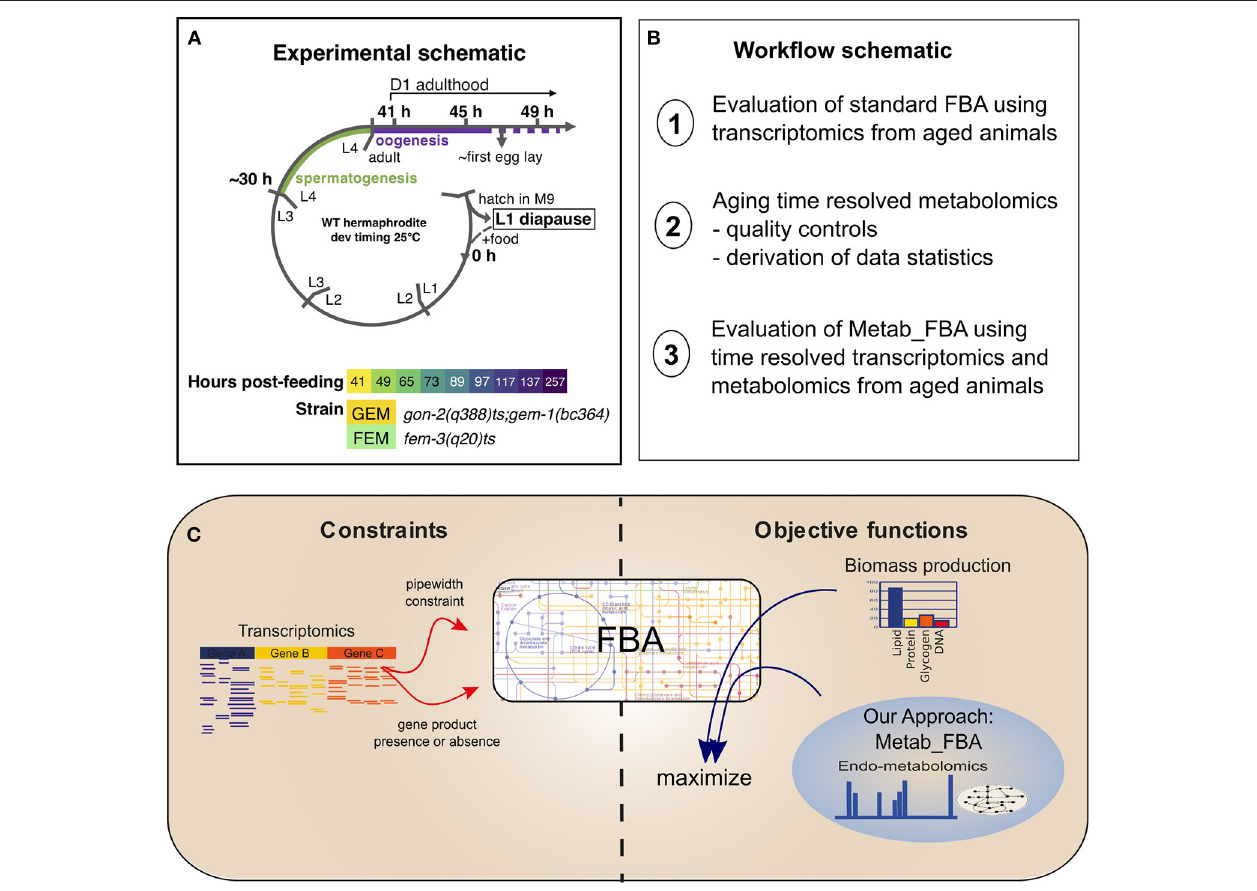
FIGURE 1 | Experimental schematic. (A) Our experimental design included two sterile strains with differing gonadal composition sampled from early D1 of adulthood (41h post-L1-feeding, which coincides with the very end of the L4 to adult molt) to D10 of adulthood (257h post-L1-feeding). For days 1 through 4, triplicate samples were obtained. For days 5 and 10, duplicate samples were obtained. L1–L4 correspond to larval stages 1–4, L1 diapause is induced by hatching eggs in the absence of food. (B) Schematic of the workflow of this article. (C) Diagram representing the methodologies used for FBA. Standard FBA uses only biomass production as an objective function, while our approach combines the standard objective function with metabolomics